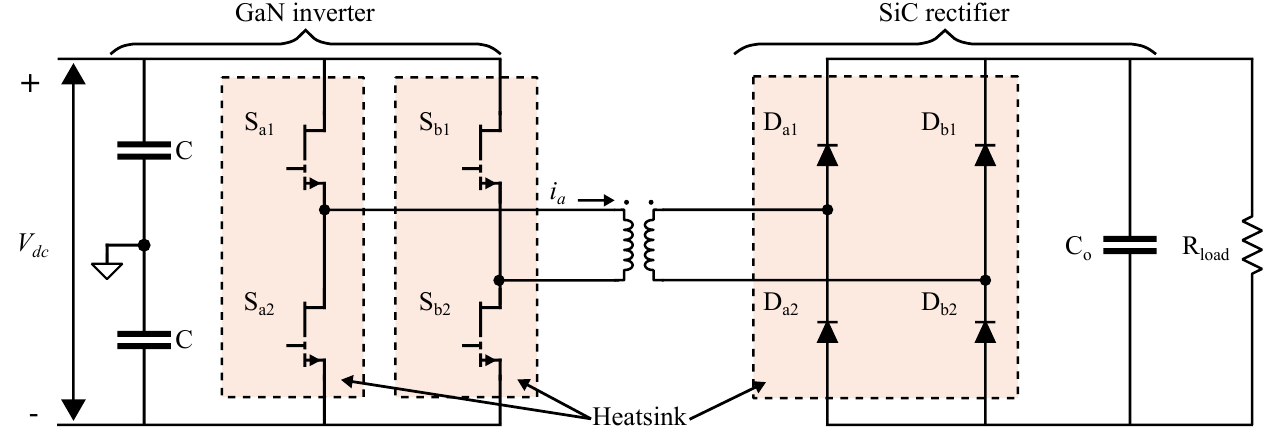
Figure 10. Schematic of the power converter. The heatsinks are drawn with dashed lines. The DC bus voltage was 300 V, and the transformer turn ratio was 2. The GaN e-HEMT GS66508B/T was used to simulate the converter switches. This device, manufactured by GaN Systems, features a maximum drain-source voltage ( V ds ) of 650 V and a continuous drain current ( I ds ) of 30 A. Each device had an external turn-on gate resistance of 10 Ω . The deadtime was 40 ns, and the turn-off gate-source voltage was 0 V. SiC C4D10120D diodes from CREE were used to model the rectifier. These diodes allowed a maximum current of 38 A, and their forward voltage was 1.4 V. The ambient temperature was